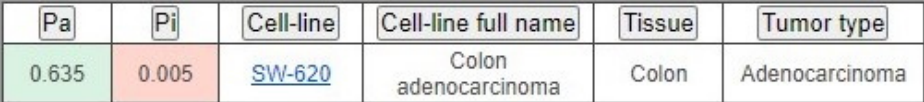
Figure 17. Cancer-cell-line prediction for L4 .